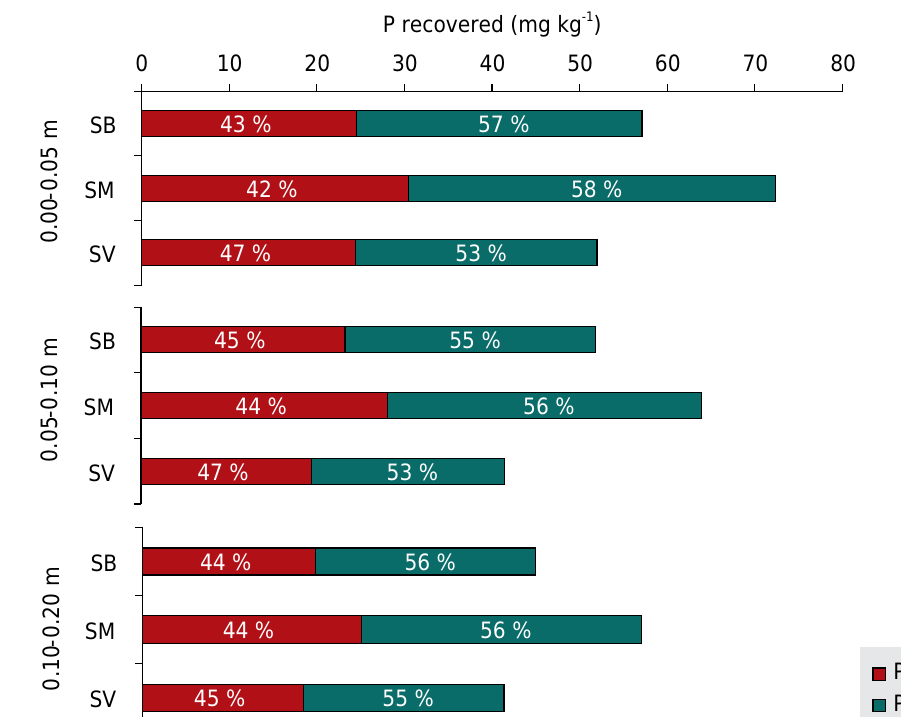
Figure 4. Percentage distribution of total organic P (Pot) and total inorganic (Pit) in relation to total P recovered, in slash-and-burn (SB), slash-and-mulch (SM) and secondary vegetation (SV) systems at different depths in an Argissolo Amarelo Distrófico